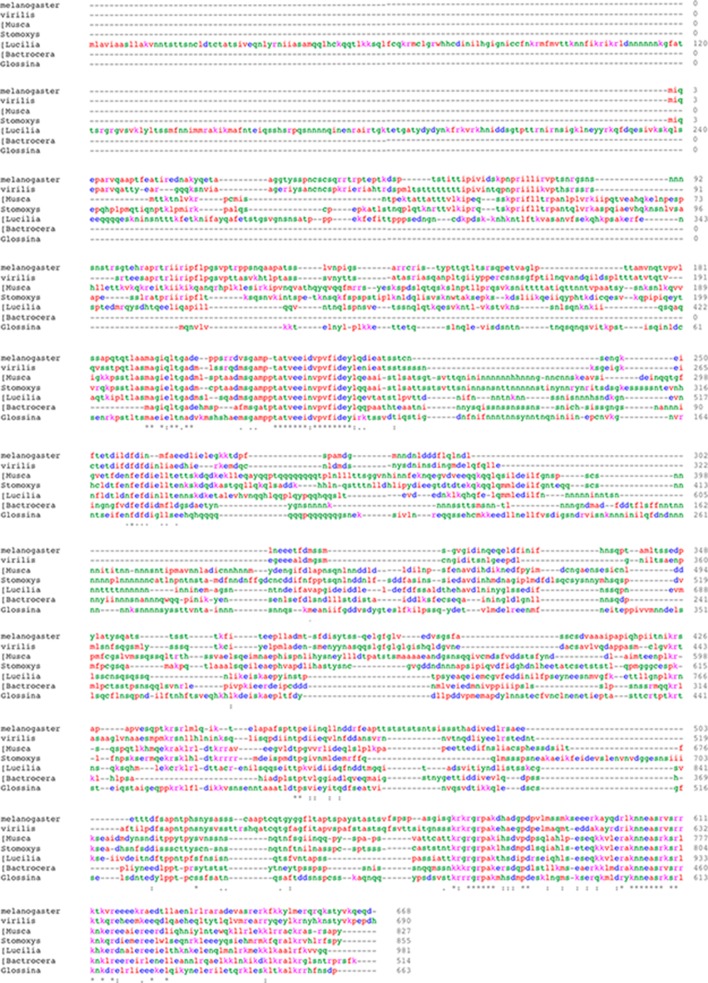
Clustal O alignment of protein sequences from the Dipteran insects Drosophila melanogaster, Drosophila virilis, Musca domestica, Stomoxys calcitrans, Lucilia cuprina, Bactrocera dorsalis, and Glossina morsitans.